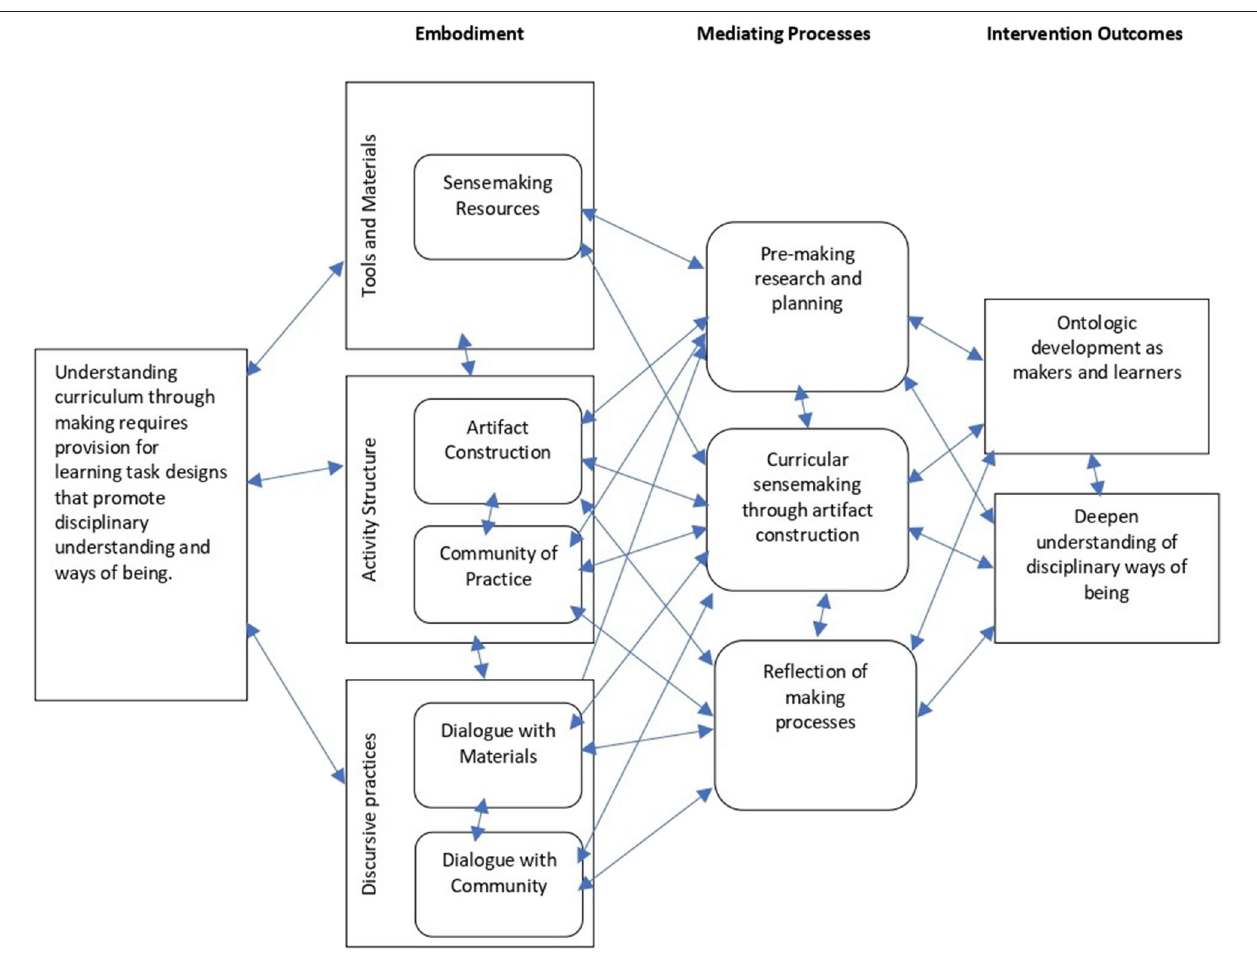
FIGURE 3 | Conjecture map detailing embodiment, meditational processes, and